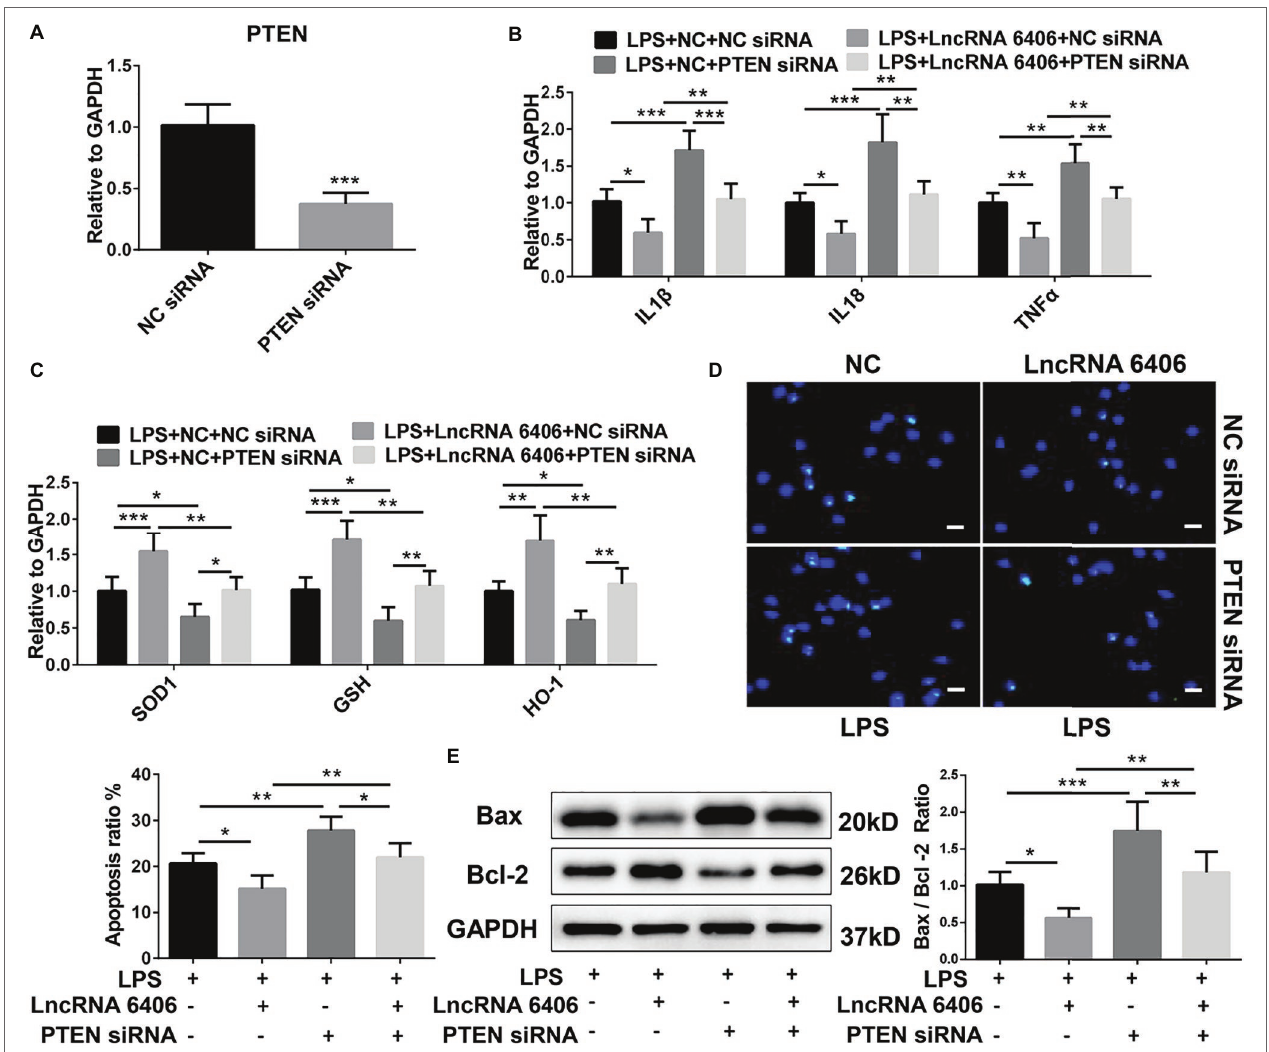
FIGURE 5 | LncRNA 6406 exerted its effect on AKI by regulating PTEN. (A) RT-PCR analysis revealed the efficacy of the PTEN siRNA ( n = 6). (B,C) The inhibition of PTEN inhibited the effect of lncRNA 6406 on inflammation and oxidative stress. (D,E) The inhibition of PTEN increased the LPS-induced apoptosis and attenuated the effect of lncRNA 6406 in PTEC cells ( n = 6), scale bar = 10 μ m. Each experiment was conducted independently three times. *p < 0.05; **p < 0.01; ***p < 0.001; versus respective